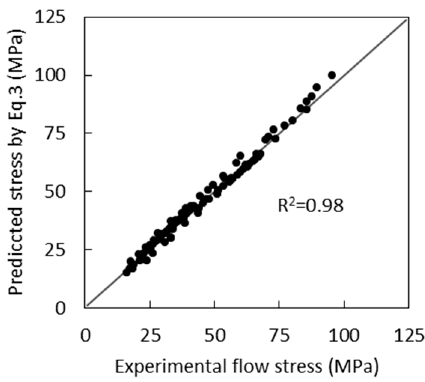
Figure 2. Comparison between experimental flow stress and predicted values by Equation (3).